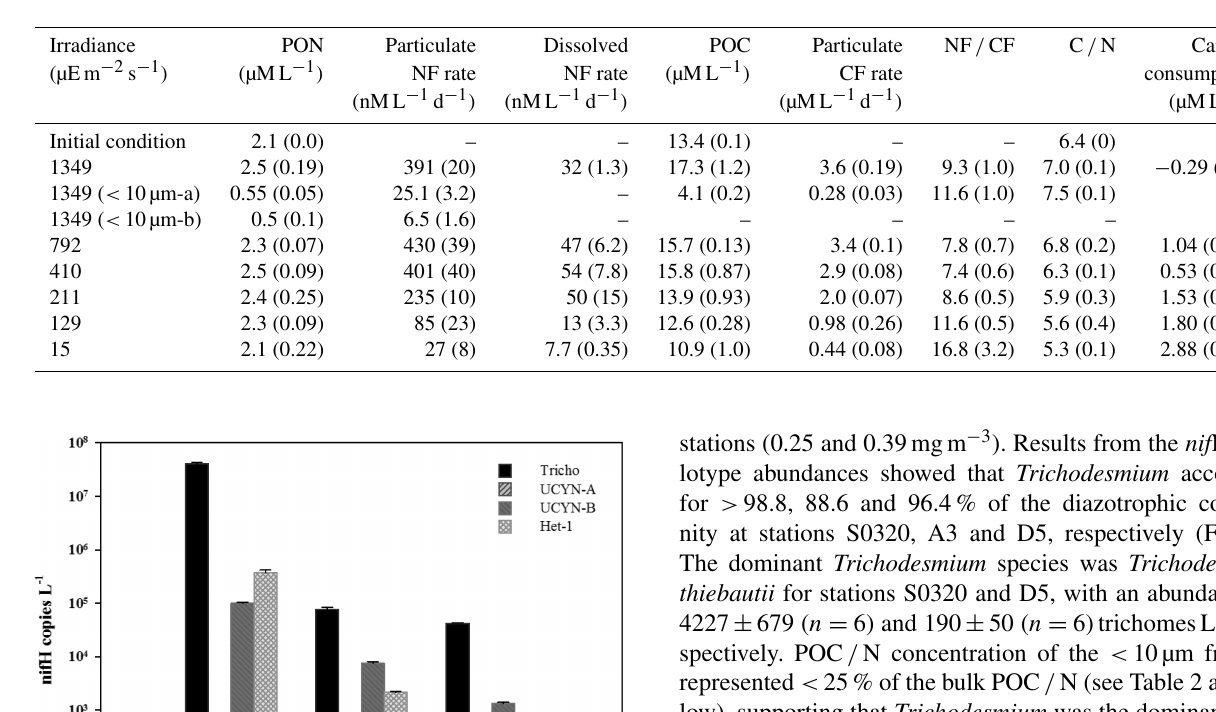
Table 2. Synthesis of PON, POC, and DON concentrations, C / N, carbon consumption and the corresponding NF and CF rates, and NF / CF at station S0320. The “ < 10µm-a” represents a NF rate of < 10µm community incubated with > 10µm Trichodesmium colonies, “ < 10µm- b” represents the background NF rate of < 10µm community, and carbon consumption was calculated using POC concentration variation from each irradiance point final concentration to initial POC concentration minus the carbon fixation rate at the corresponding irradiance point.